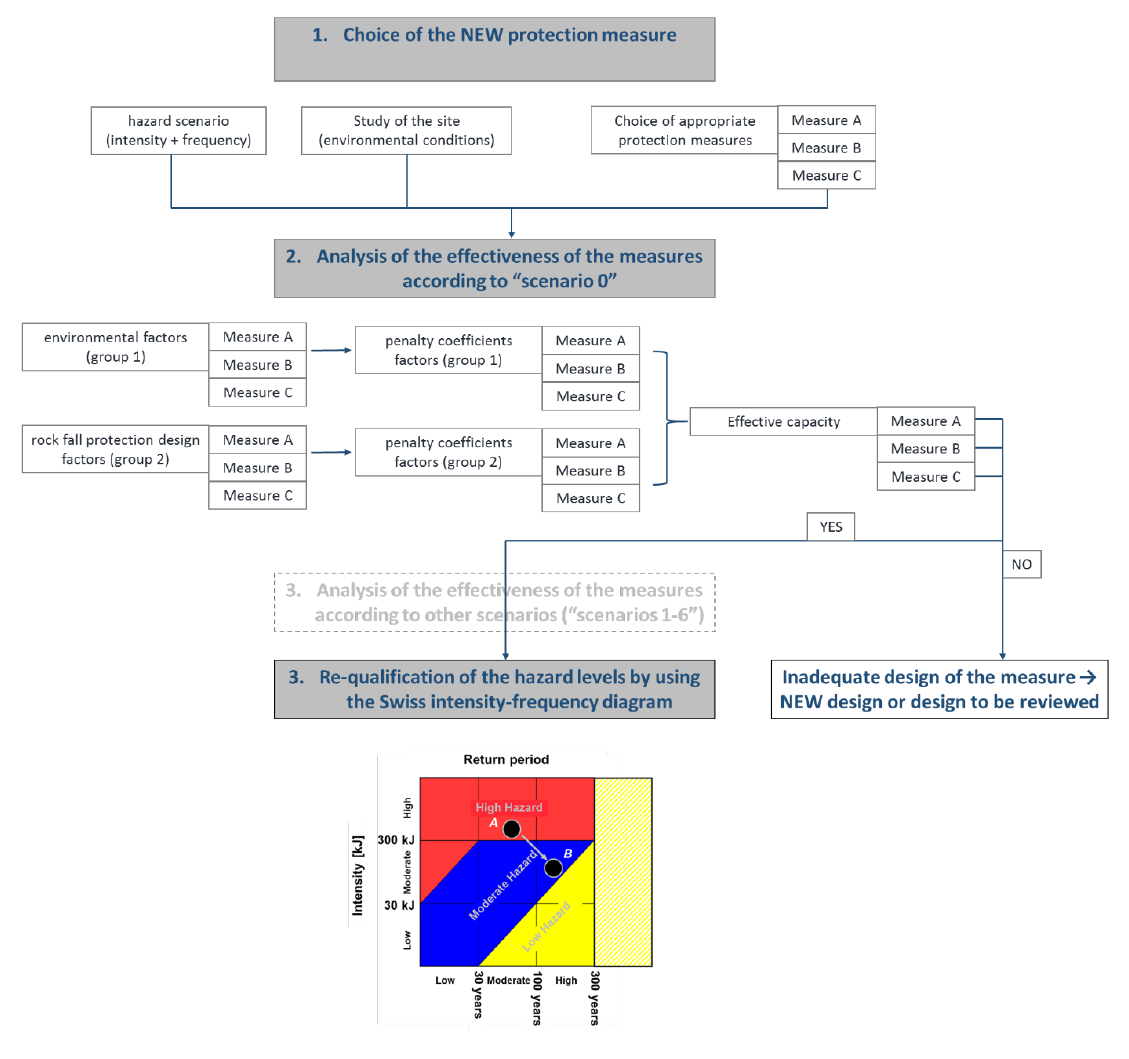
Figure 7. Flow chart of the application of the methodology for new protection